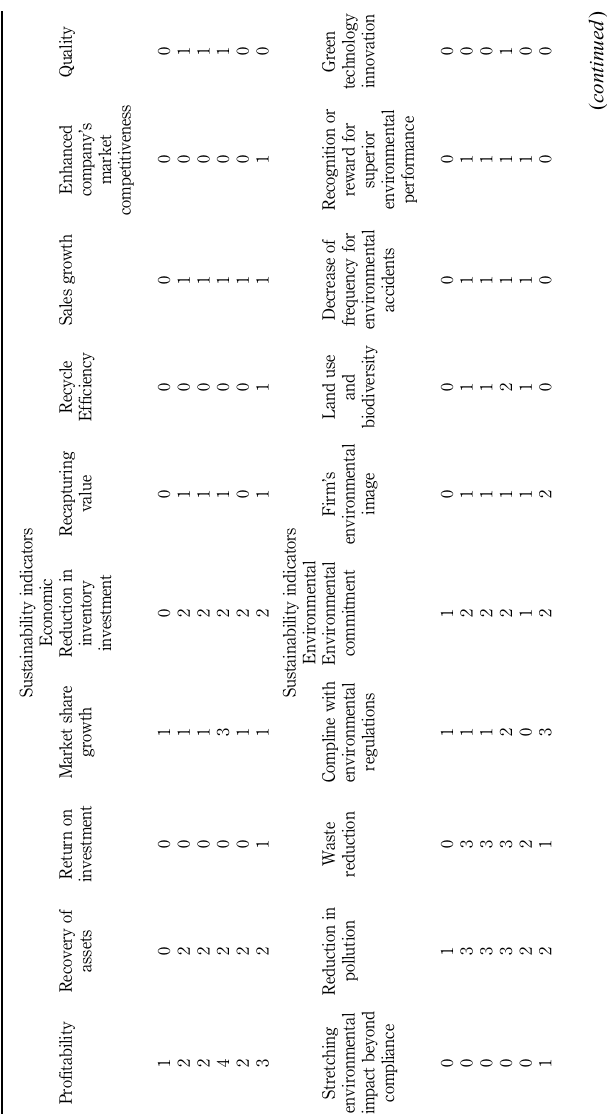
Table VII. A holistic picture of the RL system and disposition options and their respective impact on each dimension of the sustainability performance through relevant